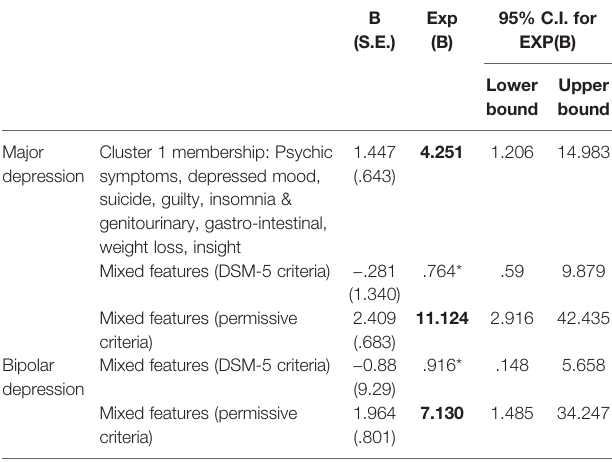
TABLE 5 | Clusters and their characterization generated by two-step cluster analysis based on the three components obtained upon Principal Component Analysis (PCA) on BD patient.